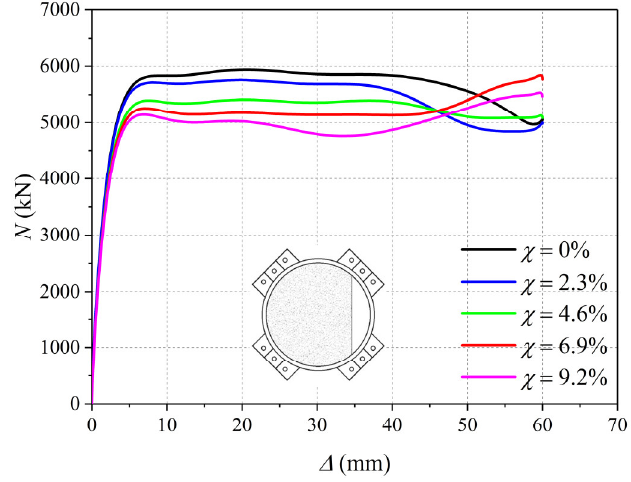
Figure 26. Simulation N - Δ curves of BWCFST short columns with spherical-cap gap.